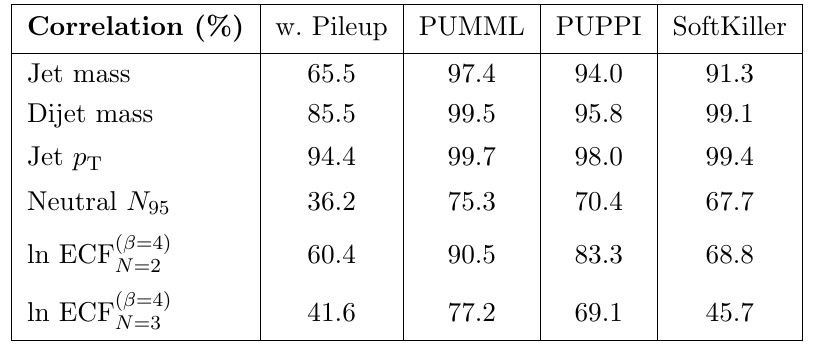
Table 1 . Correlation coe(cid:14)cients between the true and corrected values of di(cid:11)erent jet observables on an event-by-event level. The (cid:12)rst column lists the correlation without any pileup mitigation applied to the event. Larger correlation coe(cid:14)cients are better.